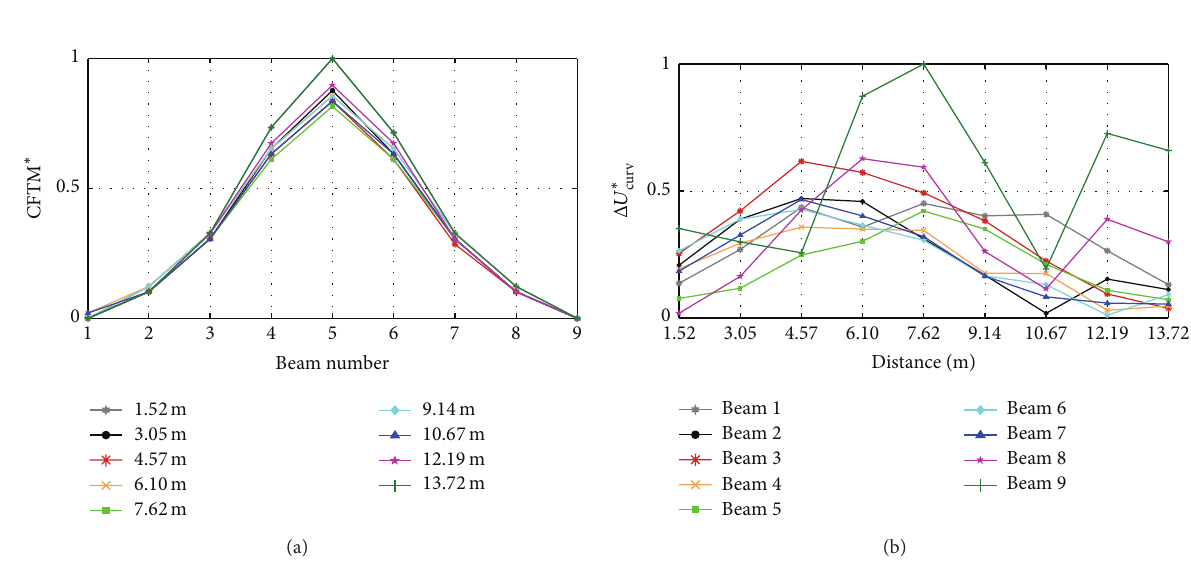
for damage case 2. curv